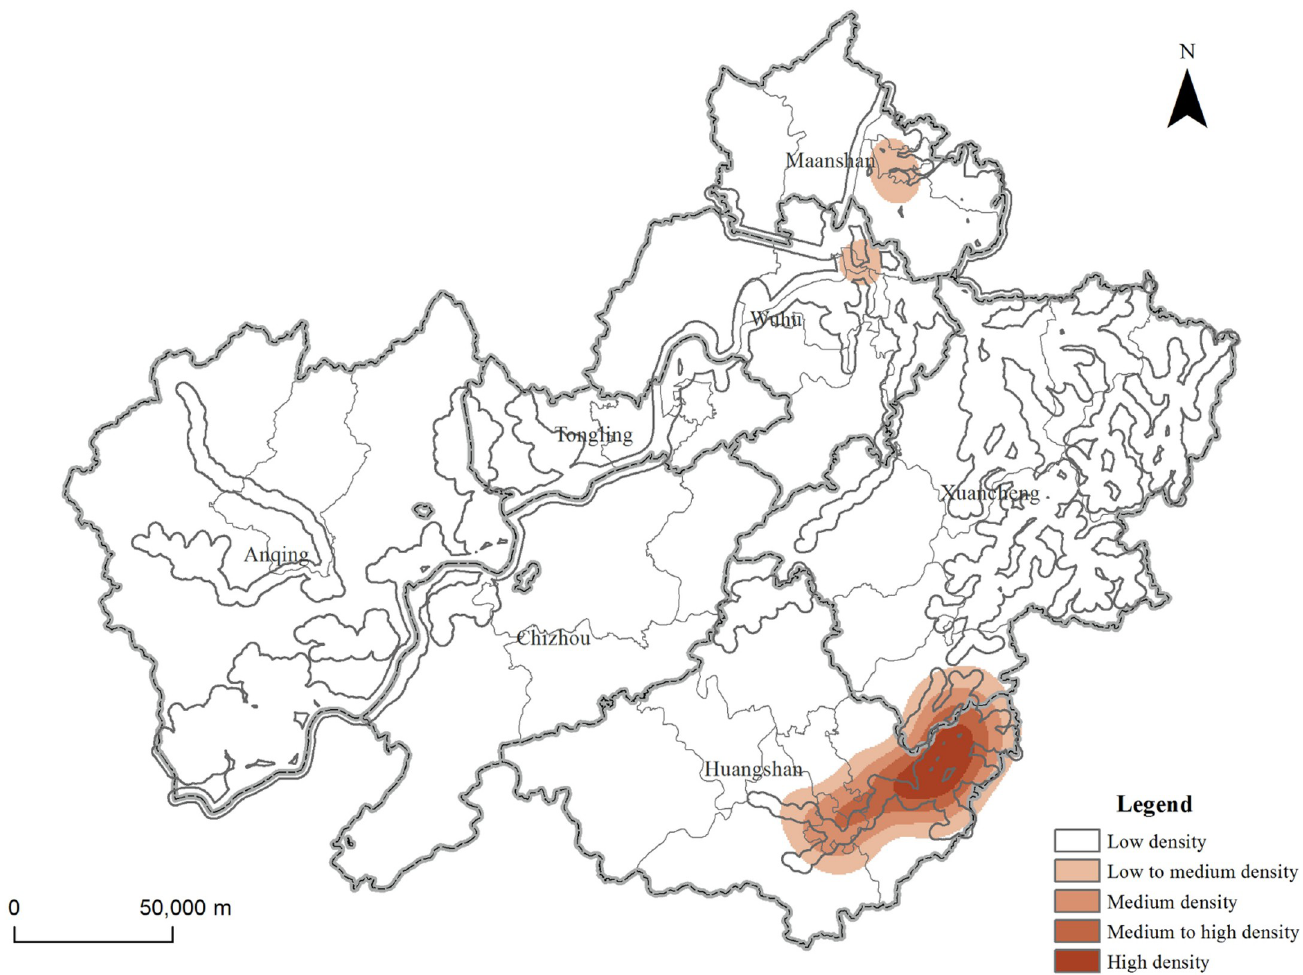
Fig 5. Analysis of tourist attractions and hydrological factors in the demonstration region. Contains information from OpenStreetMap and OpenStreetMap Foundation, which is made available under the Open Database License.